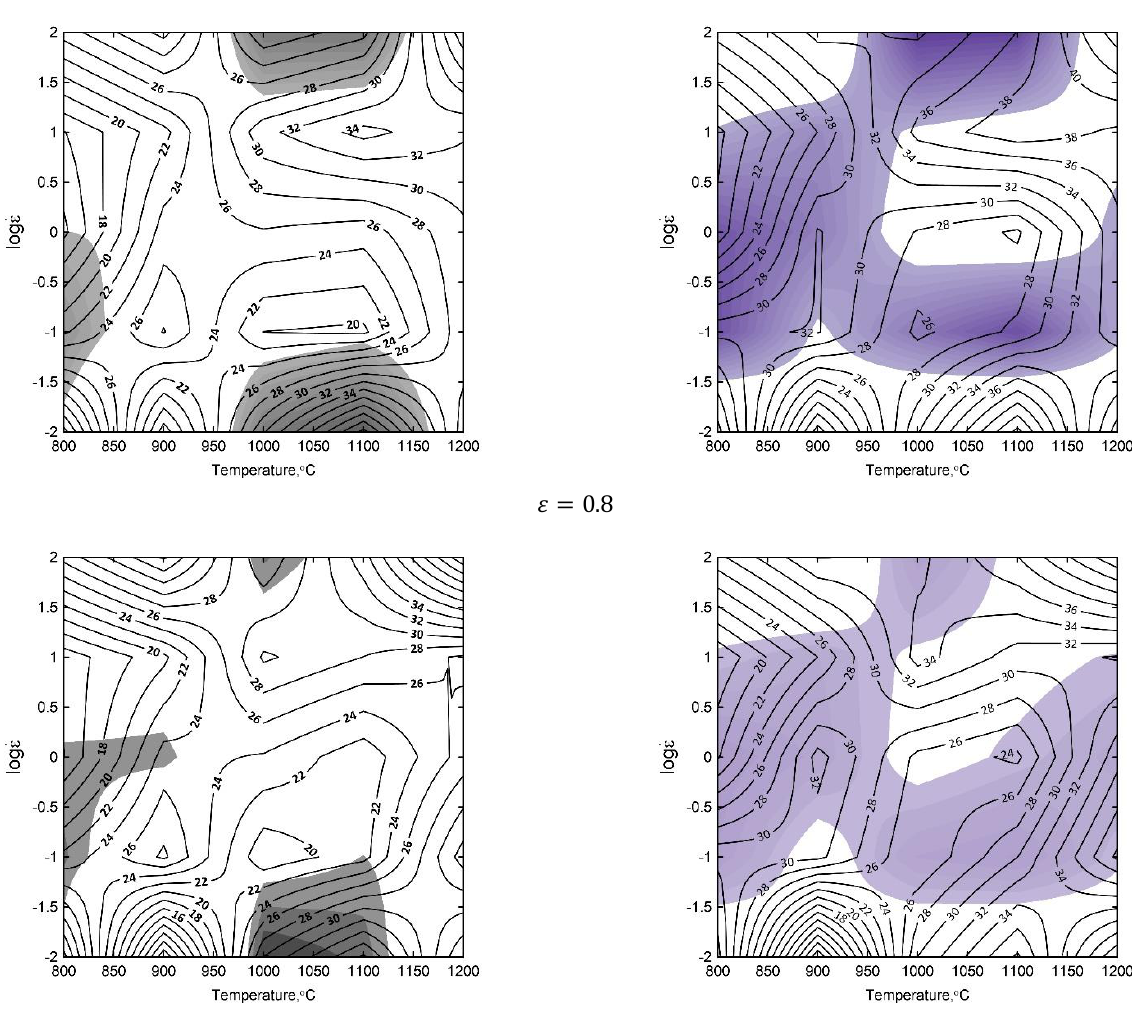
Figure 3. 4130 steel processing maps based on the Prasad’s ( a ) and Murty’s ( b ) criterion for the true strain of: 0.4, 0.6, 0.8, 1.